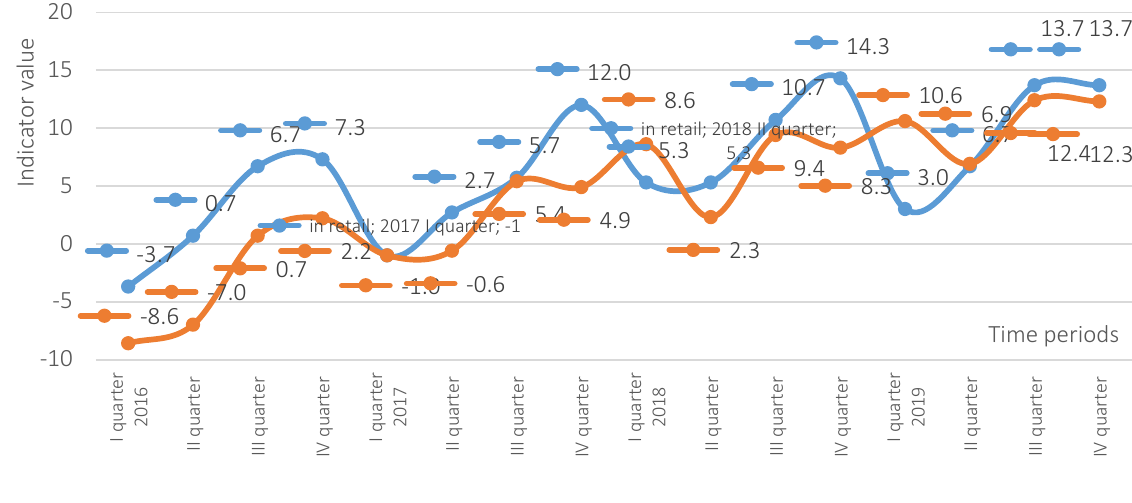
Figure 1. Indicator dynamics of entrepreneurial confidence